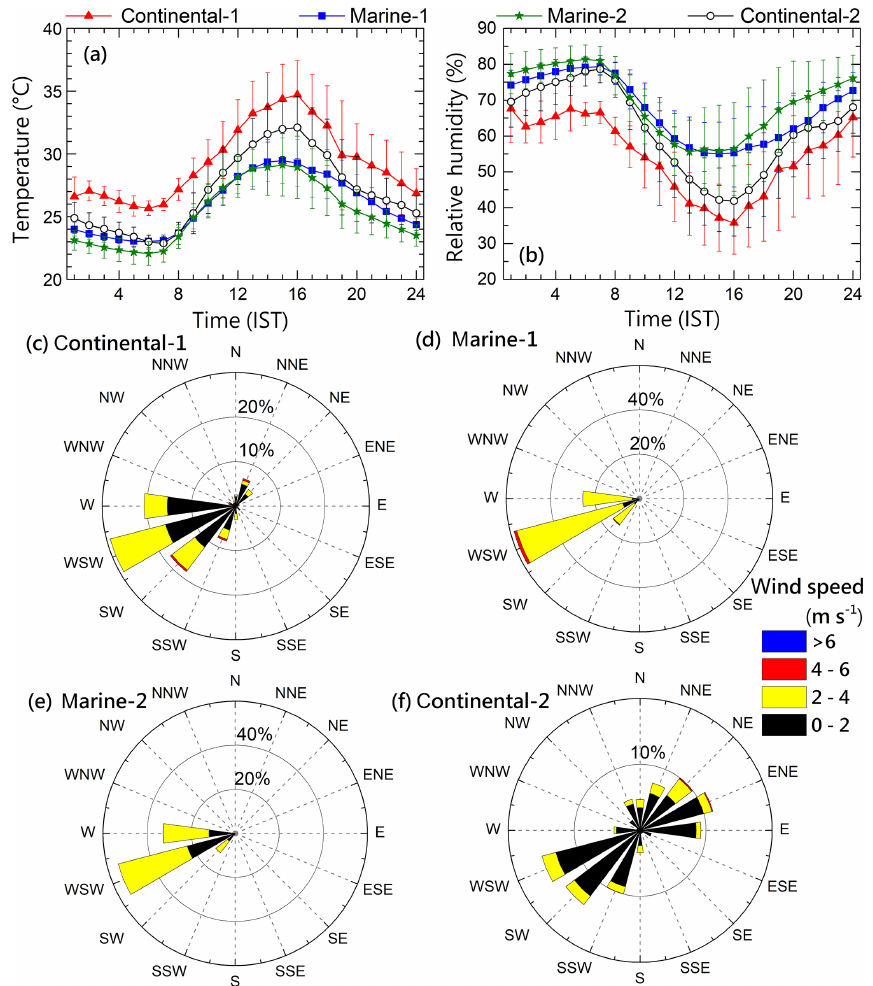
Figure 2. Diurnal variation of (a) temperature and (b) relative humidity along with the standard deviation of the mean values. The wind rose diagrams from the co-located AWS measurements for (c) continental-1, (d) marine-1, (e) marine-2, and (f) continental-2